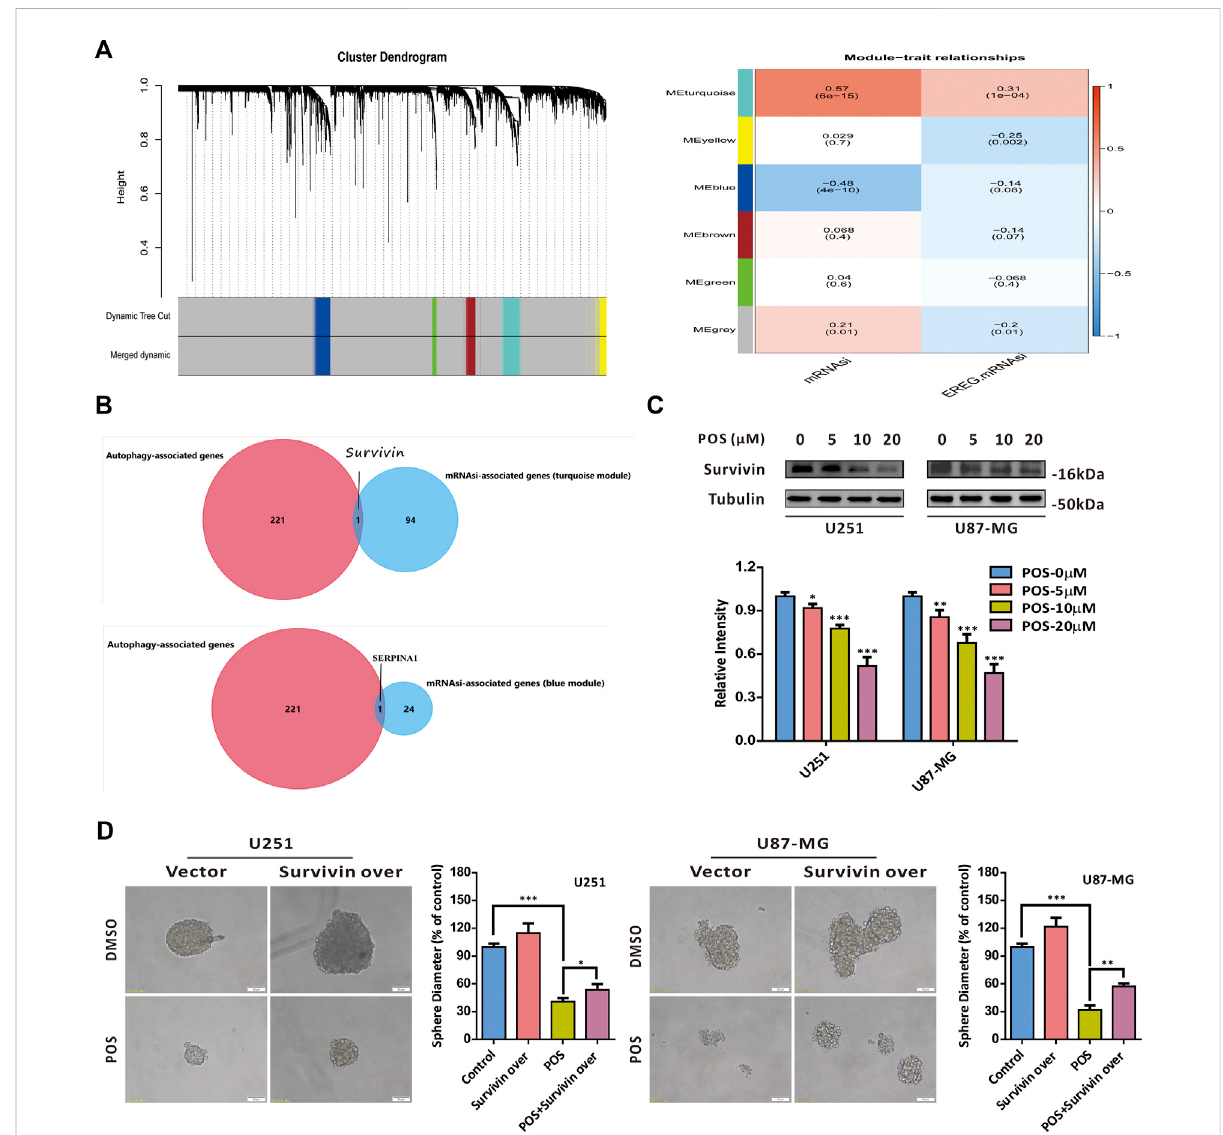
FIGURE 5 POS targets survivin to weaken CSCs stemness in GBM cells. (A) WGCNA was applied to analyze gene expression pro fi les from the TCGA databaseto fi ndcoexpressionmodulesrelatedtothestemcellindex(mRNAsiandEREG-mRNAsi)inGBMpatientscomparedtohealthycontrols. (B) Results of (A) were intersected with the autophagy-related genes provided by the human autophagy database HADb. (C) Survivin expression was detected by western blotting after cells were treated as indicated for 24 h. (D) Self-renewal capacity was detected by a sphere formation assay after the survivin-overexpressed or vector control cells were treated with POS or DMSO for 2 weeks. Scale bar, 50 μ